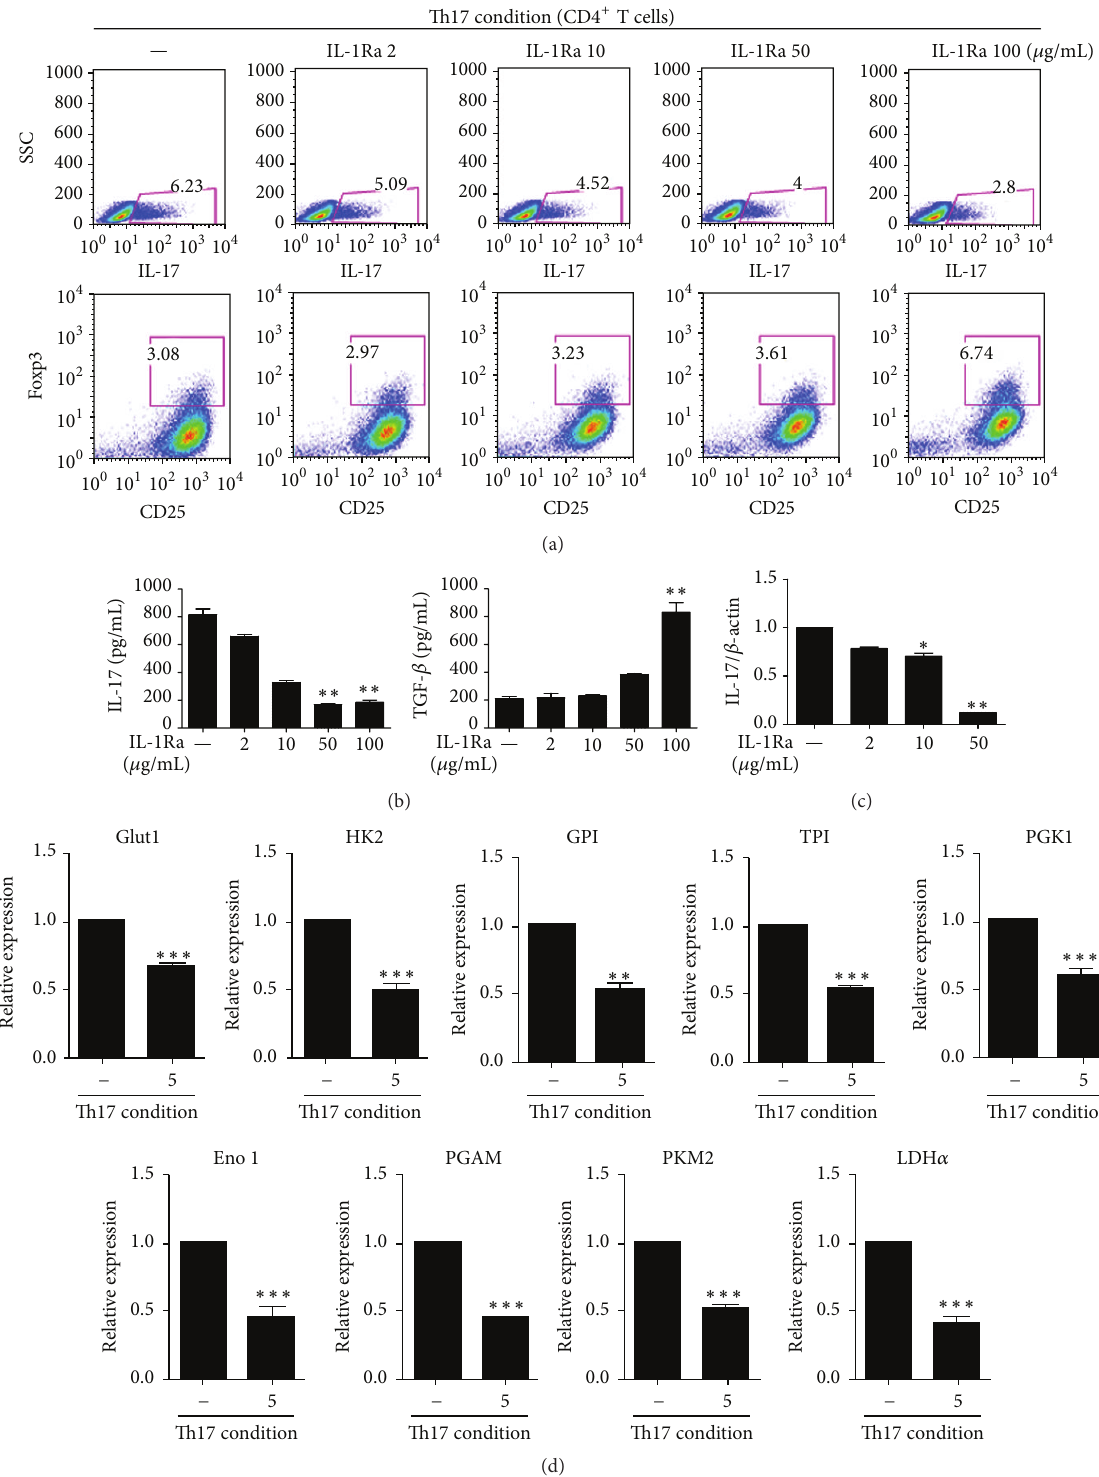
Figure 2: Treatment with IL-1Ra inhibits Th17 cell development via downregulation of the glycolysis pathway. Splenic CD4 + T cells from C57BL6 mice were cultured under Th17-polarizing conditions in the presence or absence of IL-1Ra for 3 days. (a) The proportion of Th17 cells was determined using flow cytometric analysis. (b) The supernatants were collected, and an enzyme-linked immunosorbent cells or T reg assay (ELISA) was performed to quantify the production of TGF- 𝛽 and IL-17. ((c) and (d)) The mRNA levels of IL-17 and glycolysis-related factors and enzymes were measured using real-time PCR. ∗ 𝑃 < 0.05 , ∗∗ 𝑃 < 0.01 , and ∗∗∗ 𝑃 < 0.001 . Data are representative of 2 independent